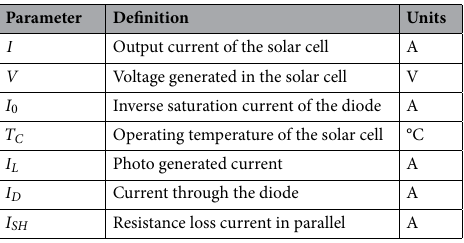
Table 2. Model variables.